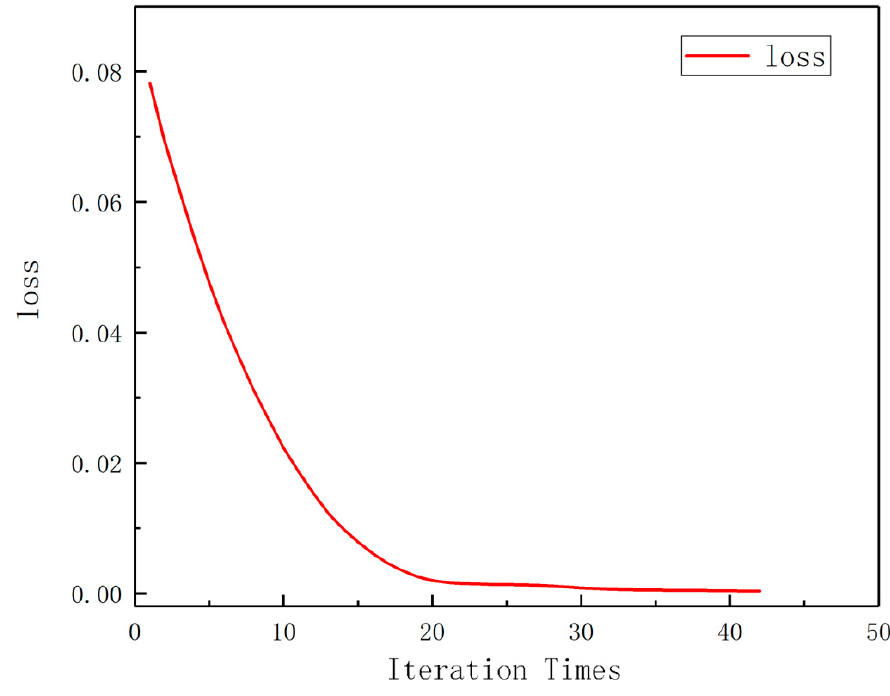
Figure 7. Loss curve of PSO-BP pressure drop model.